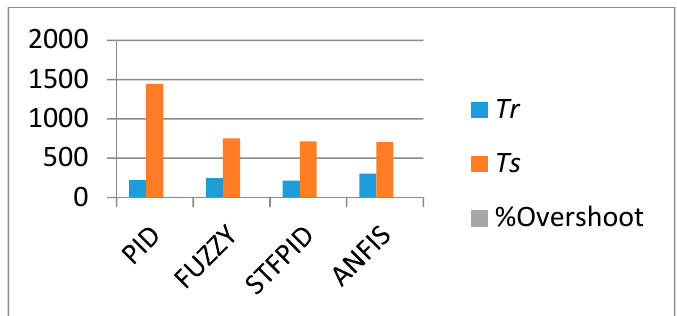
Figure 23. Ramp response of heading plane control.